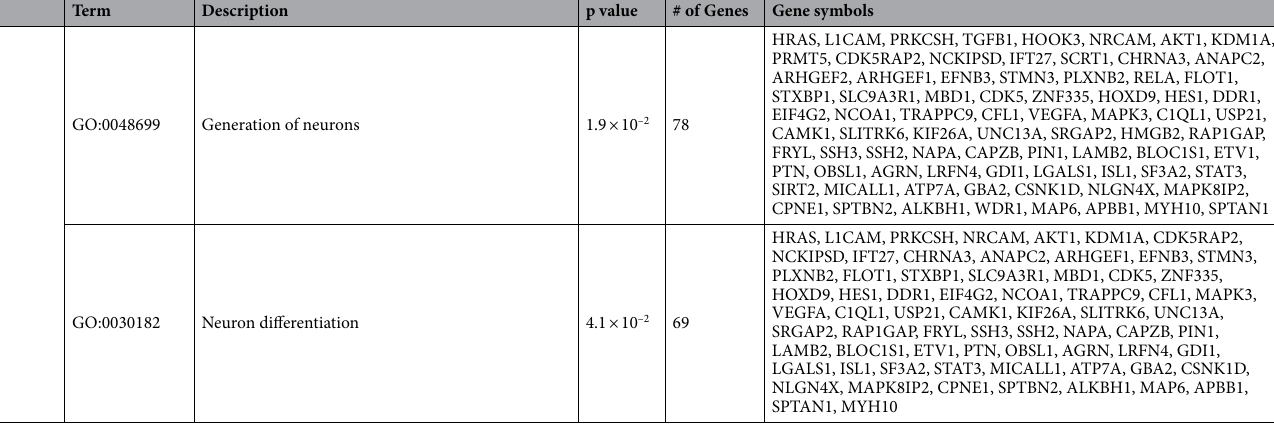
Table 1. Nervous system-related pathways that were chosen for further analysis among enriched pathways in Pea3-, Erm-, and Er81-transfected SH-SY5Y cells (including genes within the same pathways in mHypoA2/12 microarray). GO gene ontology, R-HSA reactome, path:hsa KEGG